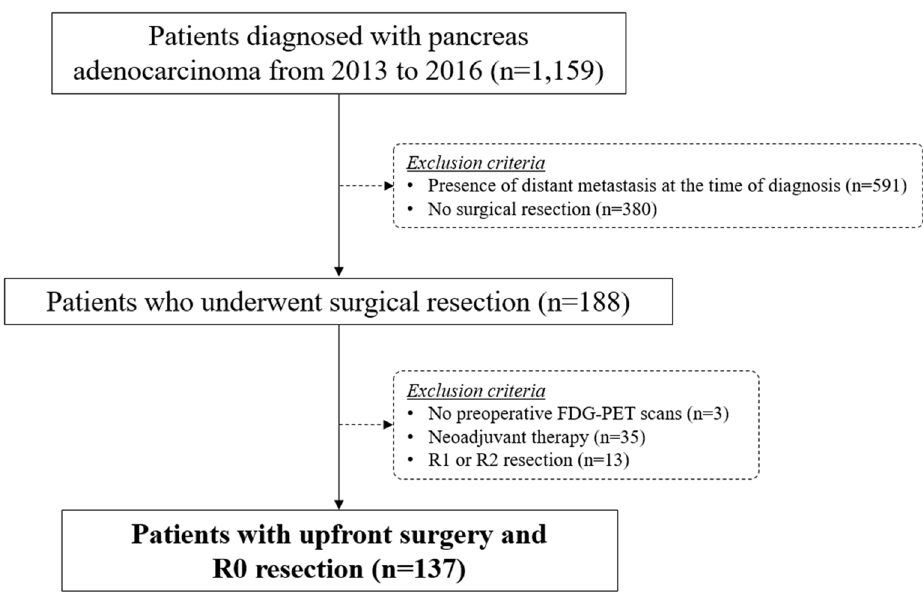
Figure 4. Flow diagram of patients included in this study. From an existing cohort of patients with pathologically proven pancreatic adenocarcinoma from 2013 to 2016, a total of 137 patients who underwent upfront surgery and successful R0 resection were eligible for the final analysis. FDG-PET , 18 F-fluoro-2- deoxyglucose-positron emission